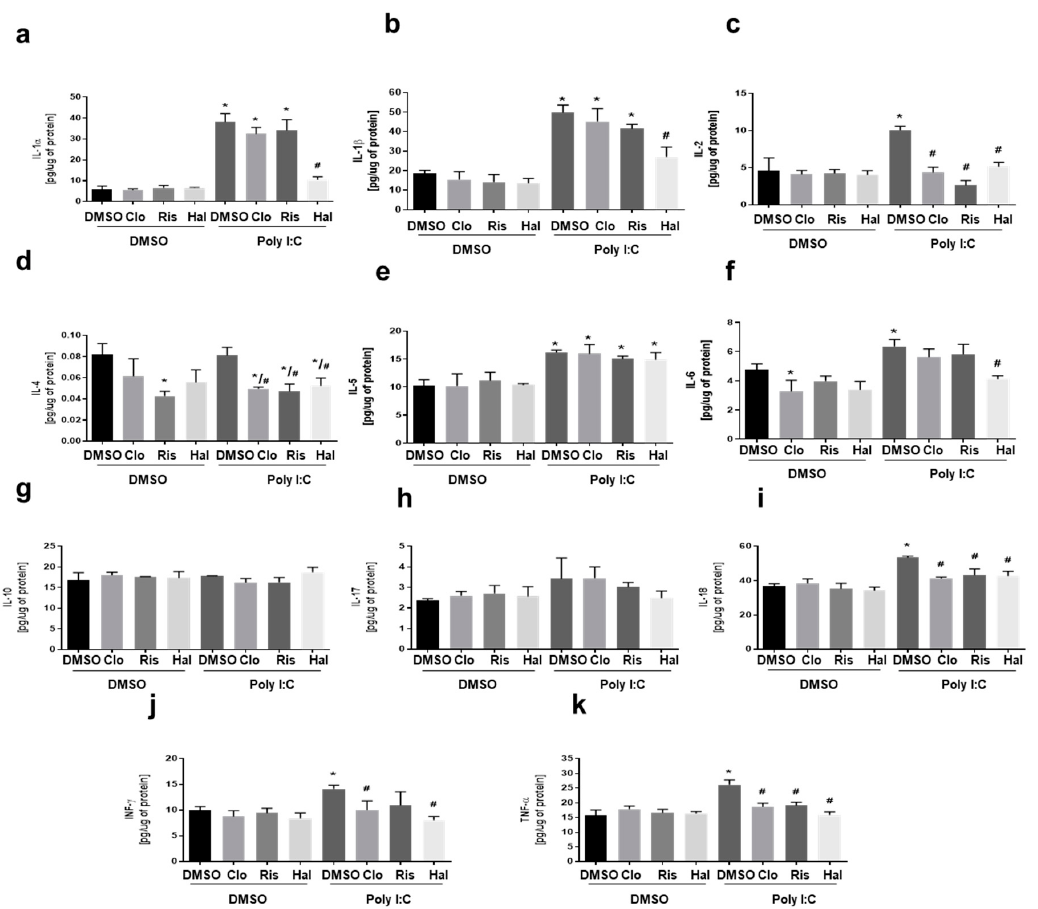
Figure 3. The effect of CRID3 on poly(I:C)-induced cytokine levels: The effect of CRID3 on the expression of ( a ) IL-1 α , ( b ) IL-1 β , ( c ) IL-2, ( d ) IL-4, ( e ) IL-5, ( f ) IL-6, ( g ) IL-10, ( h ) IL-17, ( i ) IL-18, ( j ) INF- γ , and ( k ) TNF- α cytokines in poly (I:C)-stimulated microglia. The microglia were exposed to poly (I:C) (10 μ g/mL) and then immediately treated with CRID3 at concentrations of 0.1, 1.0, or 10 μ M for 24 h. Experiments were performed with each sample in triplicate. clozapine (CLO), risperidone (RIS), and haloperidol (HAL). The data is expressed as the mean ± SD of the three independent experiments. * p < 0.05 vs. control samples. # p < 0.05 vs. poly (I:C)-treated samples.